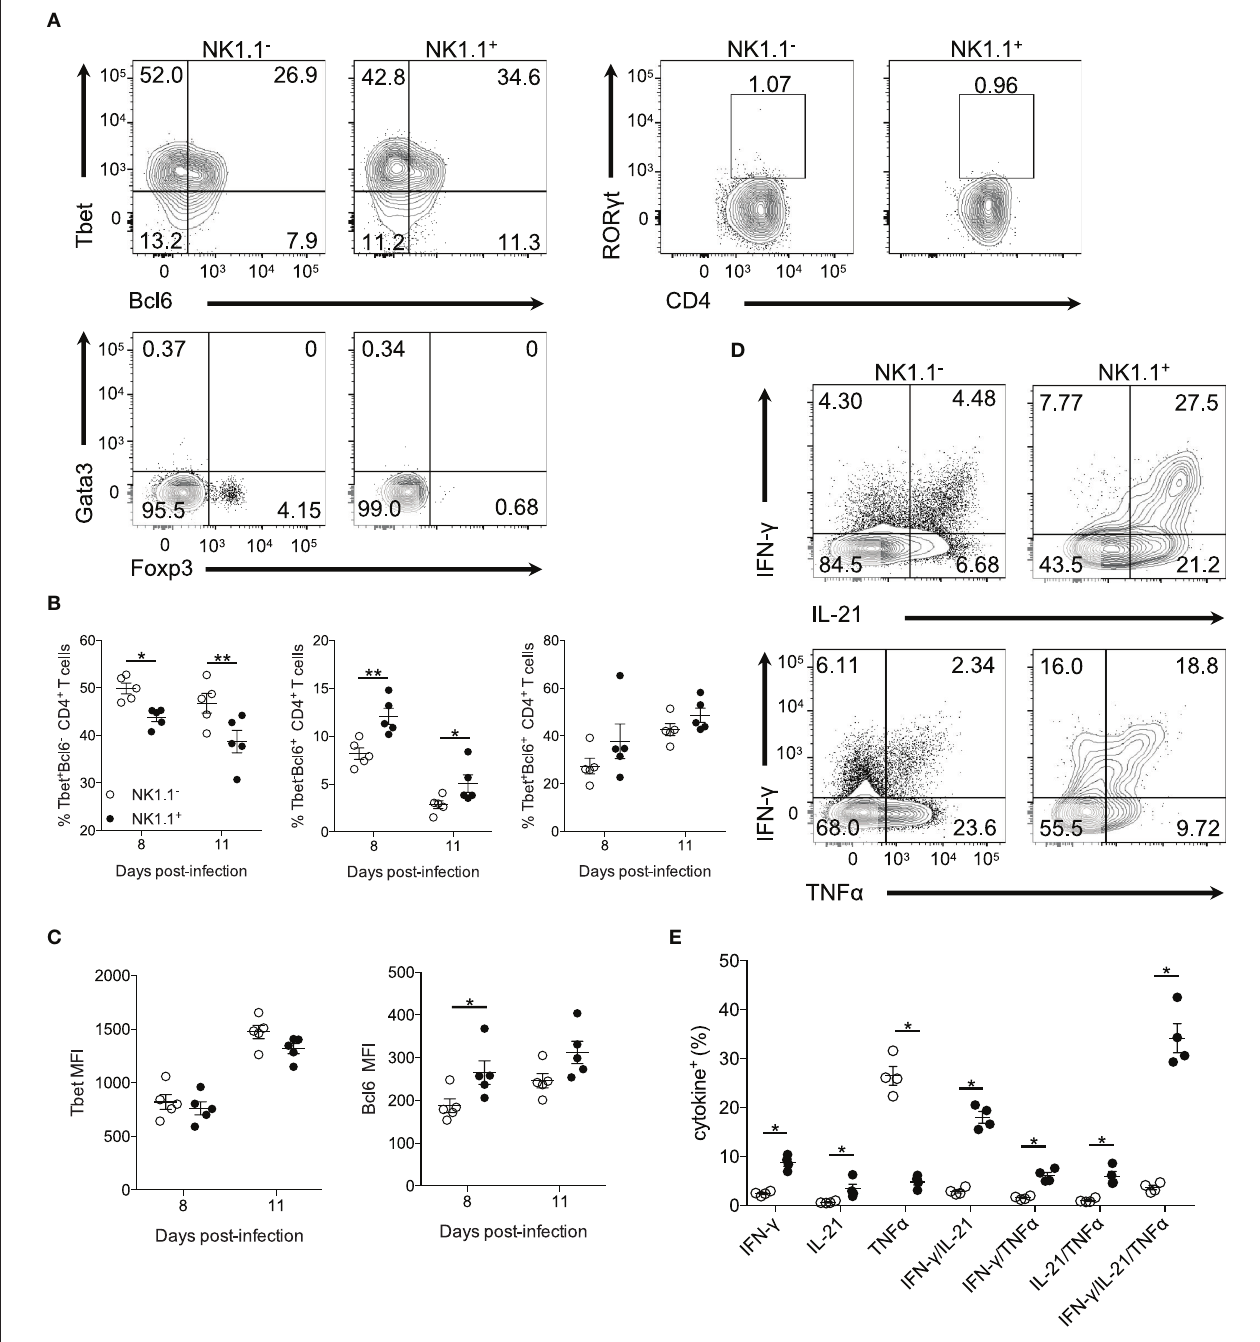
FIGURE 3 | NK1.1 + CD4 + T cells express Tbet and Bcl6 and produce effector cytokines. (A) Representative intracellular staining of NK1.1 − and NK1.1 + CD4 + T cells for the transcription factors Tbet, Bcl6, ROR γ t, Gata3, and Foxp3. Cells previously gated on live, CD44 hi CD62L lo CD4 + TCR β + splenocytes. Gates based on FMO controls shown in Supplemental Figure 4 . (B) Frequency of NK1.1 + and NK1.1 − CD4 + T cells expressing Tbet, Bcl6 or, Tbet and Bcl6 on days 8 and 11 p.i. An aligned rank transformation was performed on non-parametric data before determining significance by two-way ANOVA with a post hoc Holm-Sidak’s multiple comparisons test. * p < 0.05, ** p < 0.01. (C) Median fluorescence intensity (MFI) for Tbet and Bcl6 in NK1.1 + and NK1.1 − CD4 + T cells on day 8 and 11 p.i. An aligned rank transformation was performed on non-parametric data before determining significance by two-way ANOVA with a post hoc Holm-Sidak’s multiple comparisons test. * p < 0.05. (D) Representative intracellular cytokine staining of NK1.1 − and NK1.1 + CD4 + T cells previously gated on live CD4 + TCR β + T cells, on day 7 post-infection. Splenocytes were stimulated for 4h with PMA and ionomycin in the presence of brefeldin A before being stained for IFN- γ , IL-21, and TNF α . (E) The frequency of single, double, or triple cytokine-producing cells at day 7 post-infection. Significance assessed via an unpaired non-parametric Mann-Whitney test. * p < 0.05. Data are representative of three independent experiments (error bars, s.e.m.).